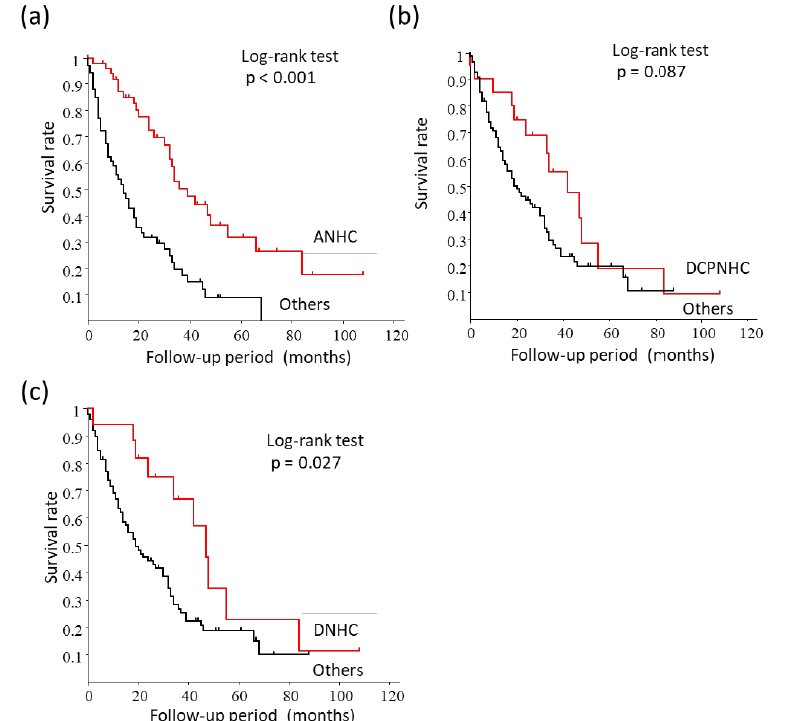
Figure 5. Survival analysis in higher-stage HCC (BCLC-B, C, and D). ( a ) Comparison